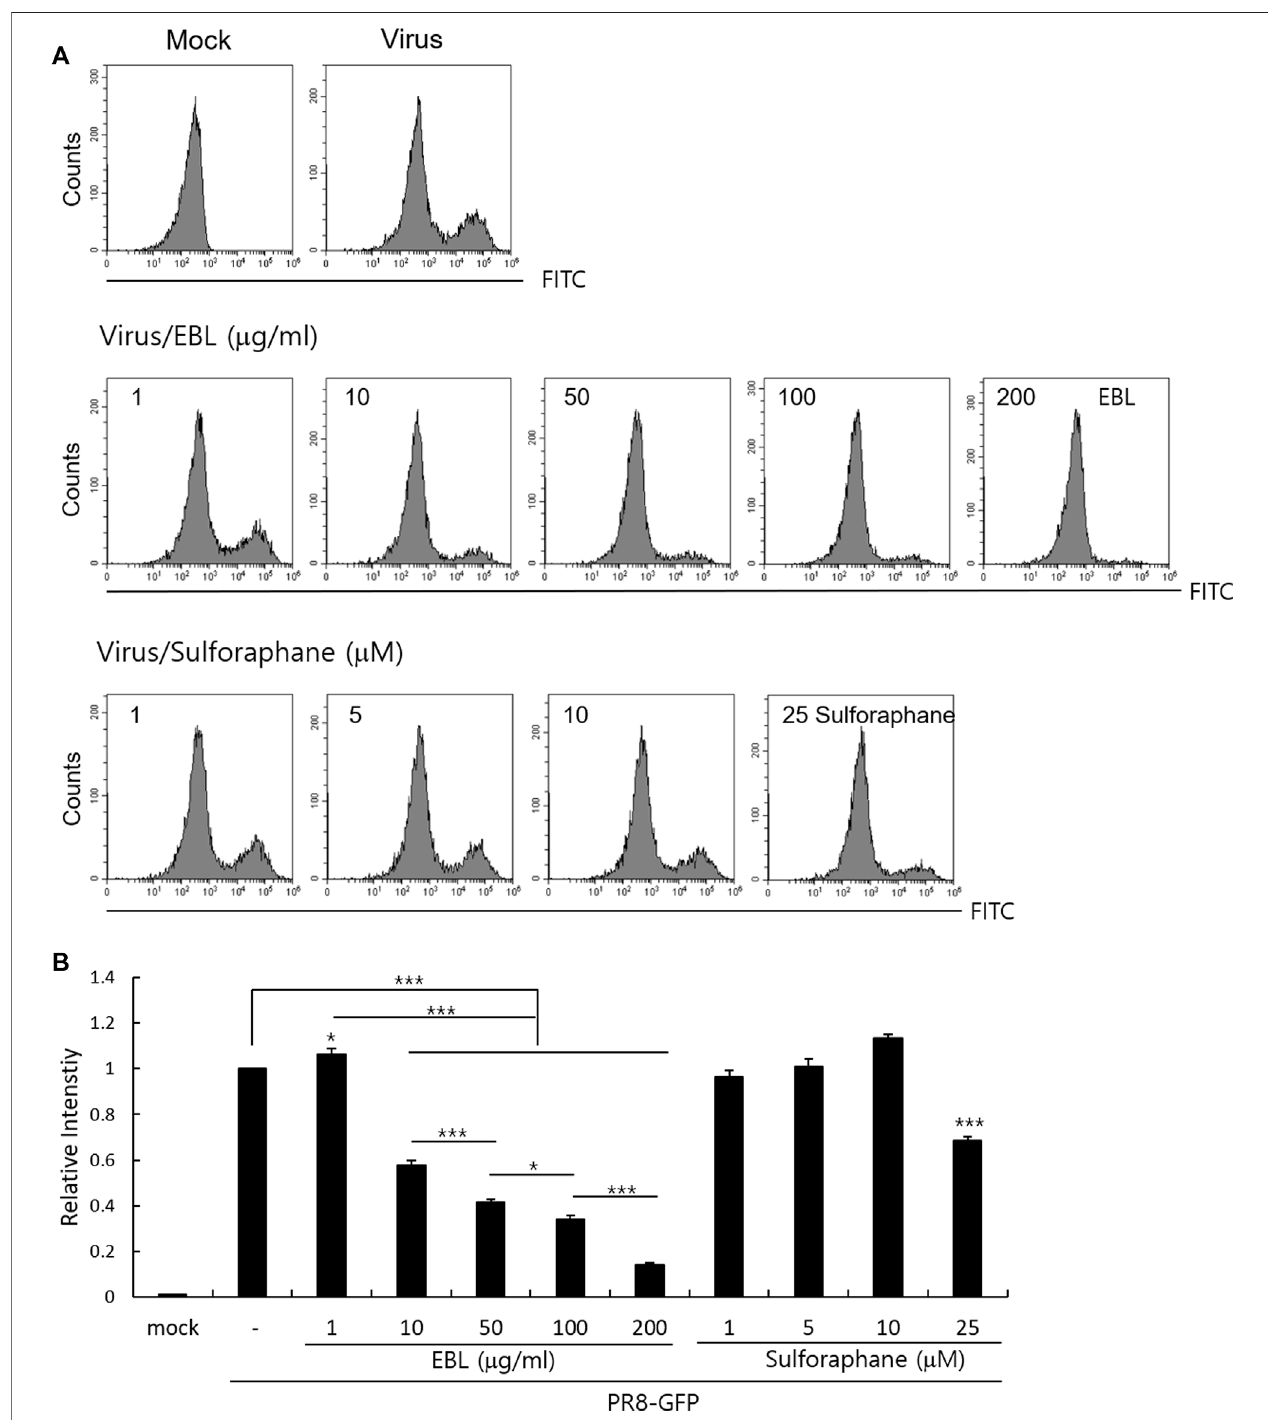
FIGURE 7 | Effect of sulforaphane on IAV infection. (A,B) EBL or sulforaphane at indicated concentrations was mixed with PR8-GFP IAV and cotreated to RAW 264. 7 cells. The cells were washed with PBS at 24 h post infection, fi xed with 4% paraformaldehyde, and resuspended in PBS for FACS analysis. The levels of GFP expression were depicted as relative intensities compared to those of the control PR8-GFP IAV. The data represent the mean ± SD based on three independent experiments. Statistical signi fi cance was assessed via an unpaired Student T-test. *** p < 0.005, ** p < 0.01, and * p < 0.05.